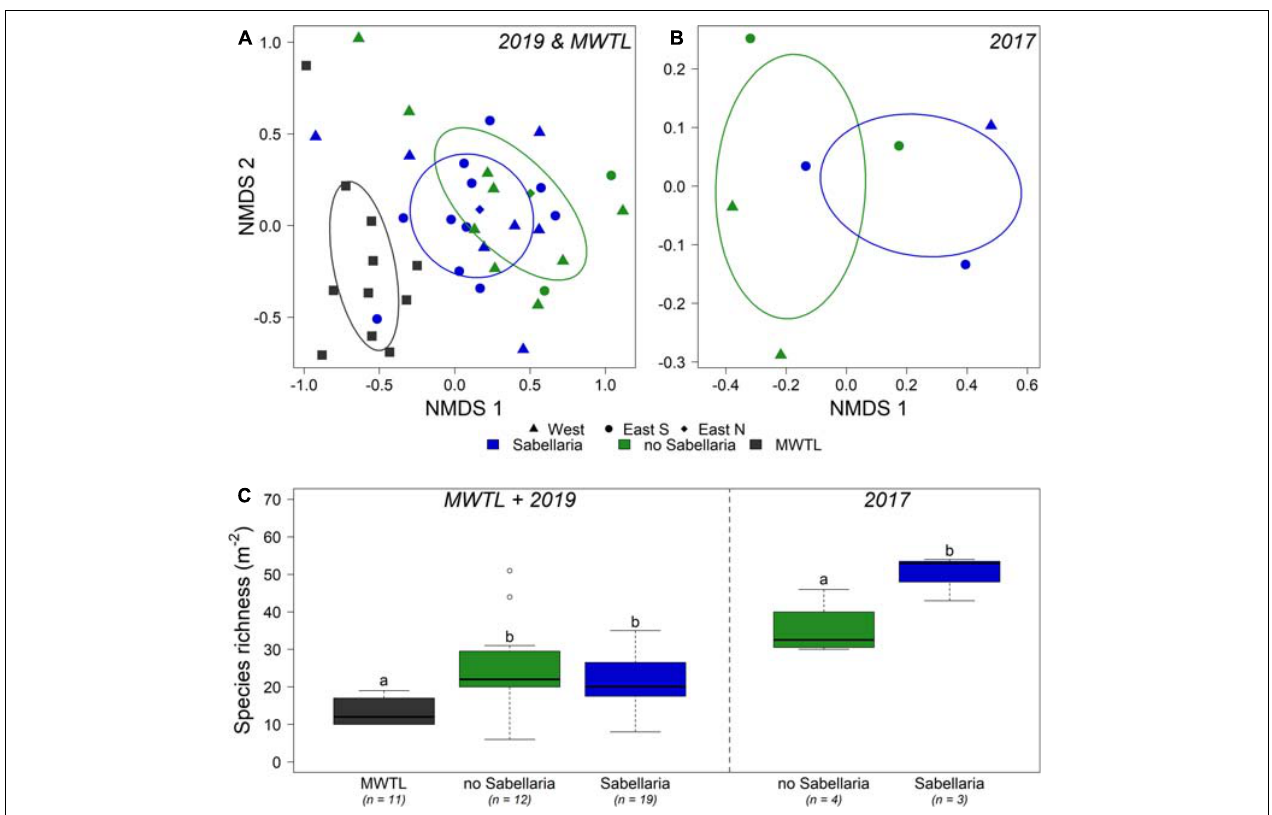
FIGURE 5 | Comparison of endobenthos data between both research campaigns and the MWTL survey. (A) NMDS of endobenthos data gathered in the joint MWTL survey and the 2019 campaign, and for (B) the 2017 campaign. Samples with video-based observed Sabellaria habitat within a 50 m distance are blue; samples without Sabellaria habitat are green. Circles show the western trough, triangles the eastern trough south, and diamonds the eastern trough north. (C) species richness (Nm − 2 ) is shown per habitat for the MWTL survey and 2019 campaign combined, and separately for the 2017 campaign. n represents the number of boxcores included. Significant differences are represented by different letters. Note that the 2017 campaign data are analyzed separately from the MWTL survey and 2019 campaign